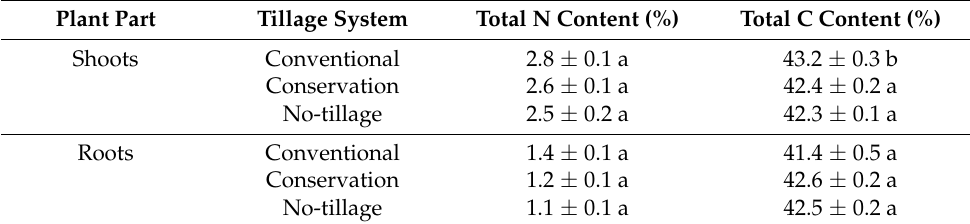
Table 4. Total nitrogen and carbon contents in soybean shoots and roots according to the different tillage systems.